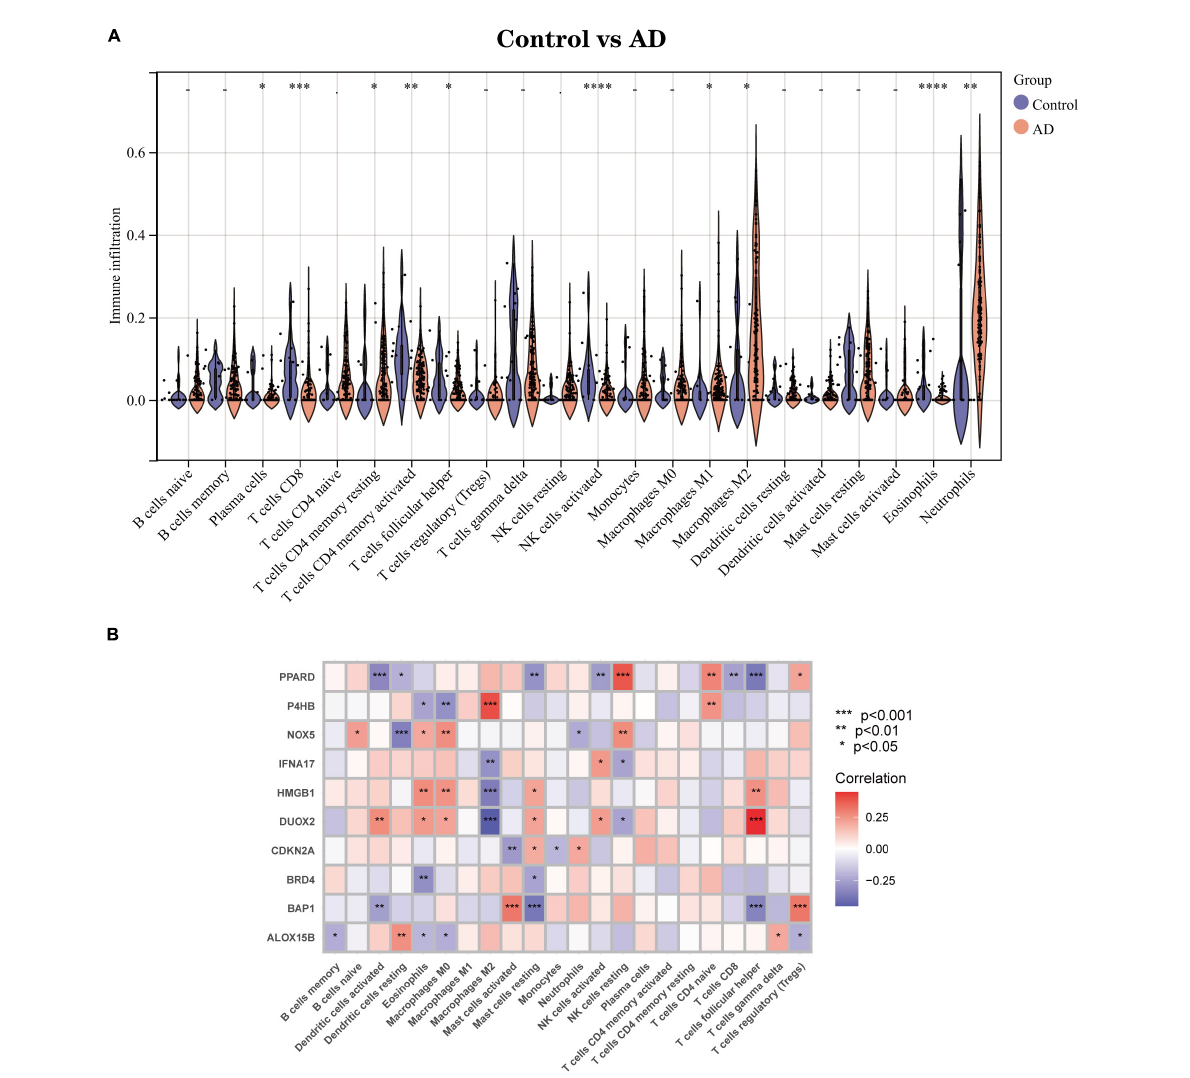
FIGURE8 Immune infiltration landscape between AD and Control obtained by CIBERSORT analysis. (A) Violin plot showing the difference in immune cell infiltration between AD (red) and Control (purple), P < 0.05, was considered statistically significant. (B) Shows the correlation between Hub genes and immune cells. The colors from red to purple represent the change from positive to negative correlations, respectively. More asterisks and darker colors of the modules represent stronger correlations. ∗ P < 0.05; ∗∗ P < 0.01; ∗∗∗∗ P < 0.001.